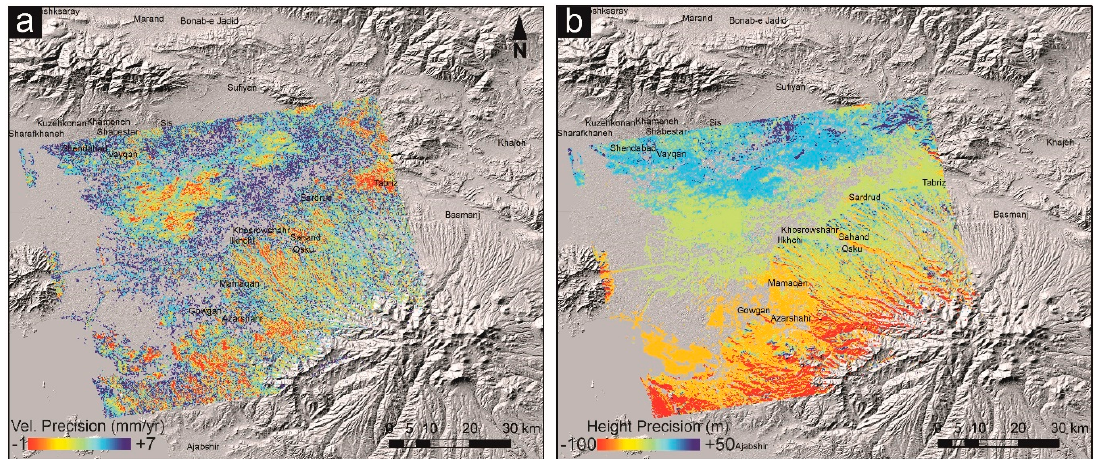
Figure A1. ( a ) Velocity precision of SBAS analysis and ( b ) height precision of SBAS analysis.